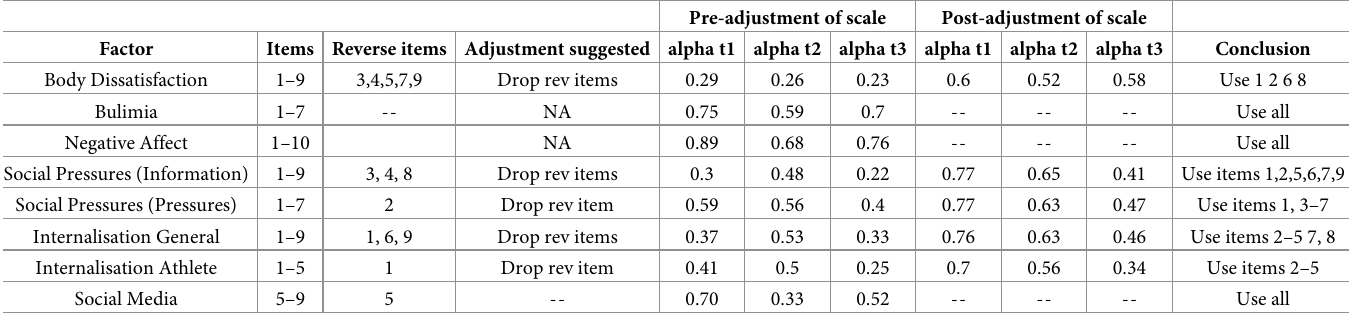
Table 2. Across time reliabilities.